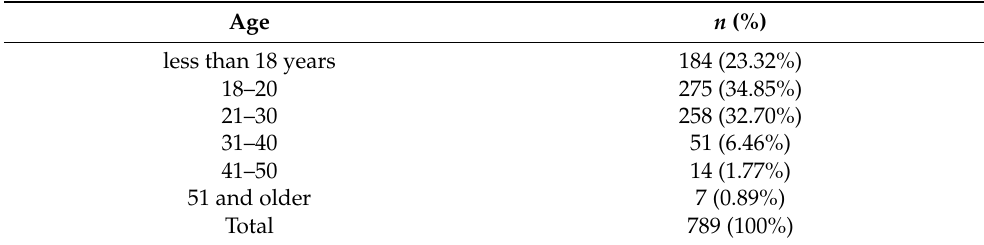
Table 3. Frequency of Age.